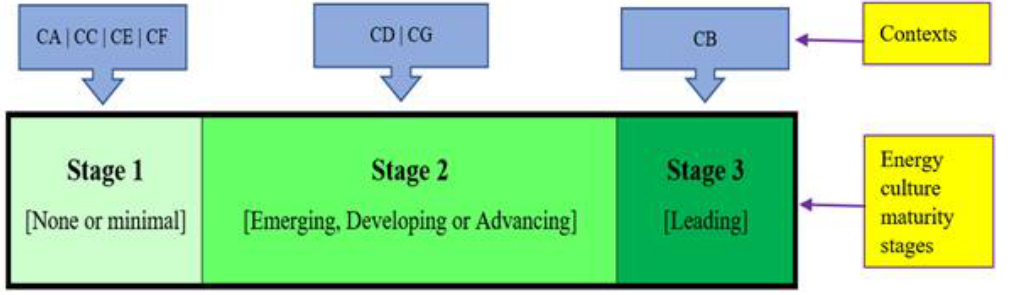
Figure 6. Grouping contexts under energy culture maturity stages (Source: Author developed).